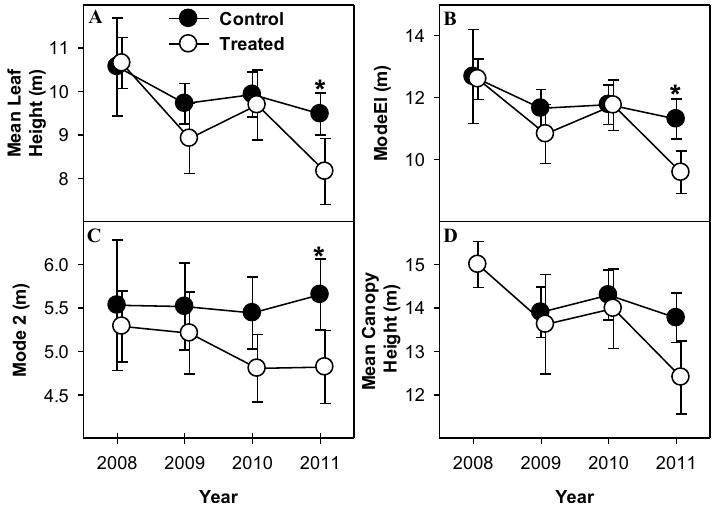
Figure 4. Metrics of canopy height demonstrate reductions in height of girdled stands. Mean leaf height ( A ) height of maximum leaf density (modeEl) ( B ) mean height of maximum leaf area density (Mode2) ( C ) and mean maximum canopy height, ( D ), all indicate greater declines in height in treated stands than control stands. Values are means of paired treated and control plots with standard error bars representing between-plot variation. * indicate significant differences between treated and control plot means.